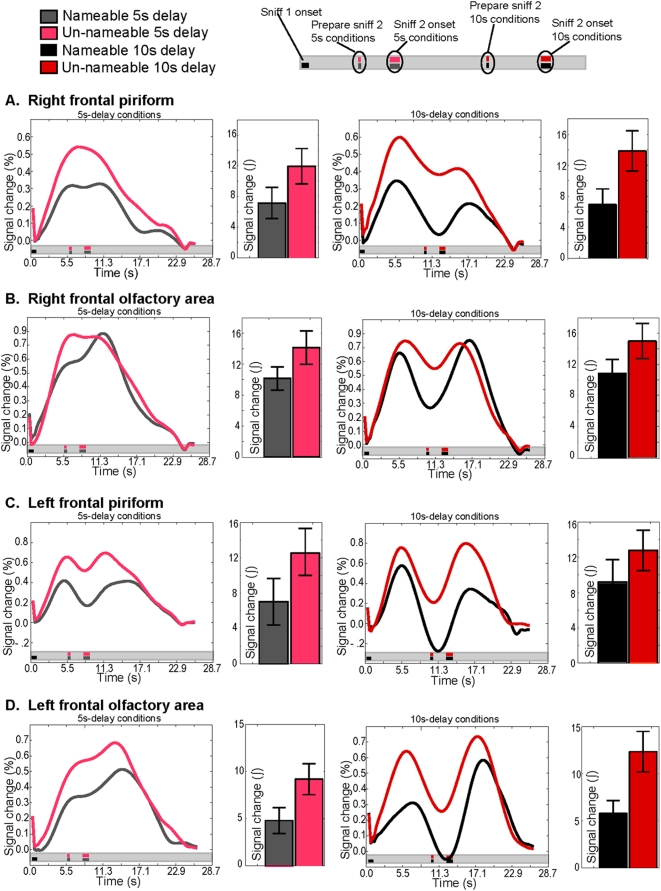
Activity in piriform cortex in response to sniff-one.Each row of the figure shows the deconvolved time course of activity in each region. In each row, the left panel shows the nameable and unnameable 5-second-delay conditions while the right panel shows the nameable and unnameable 10-second-delay-conditions. To the right of each panel is the binned response of each condition. Bar graphs depict the integral under the curve in response to sniff-one of the delayed match to sample task. Error bars represent the standard error. In all subregions shown in the figure, smelling unnameable odorants elicited more activity than nameable odorants. A. Activity in right frontal piriform cortex. B. Activity in right frontal olfactory area. C. Activity in left frontal piriform cortex. D. Activity in left frontal olfactory area.